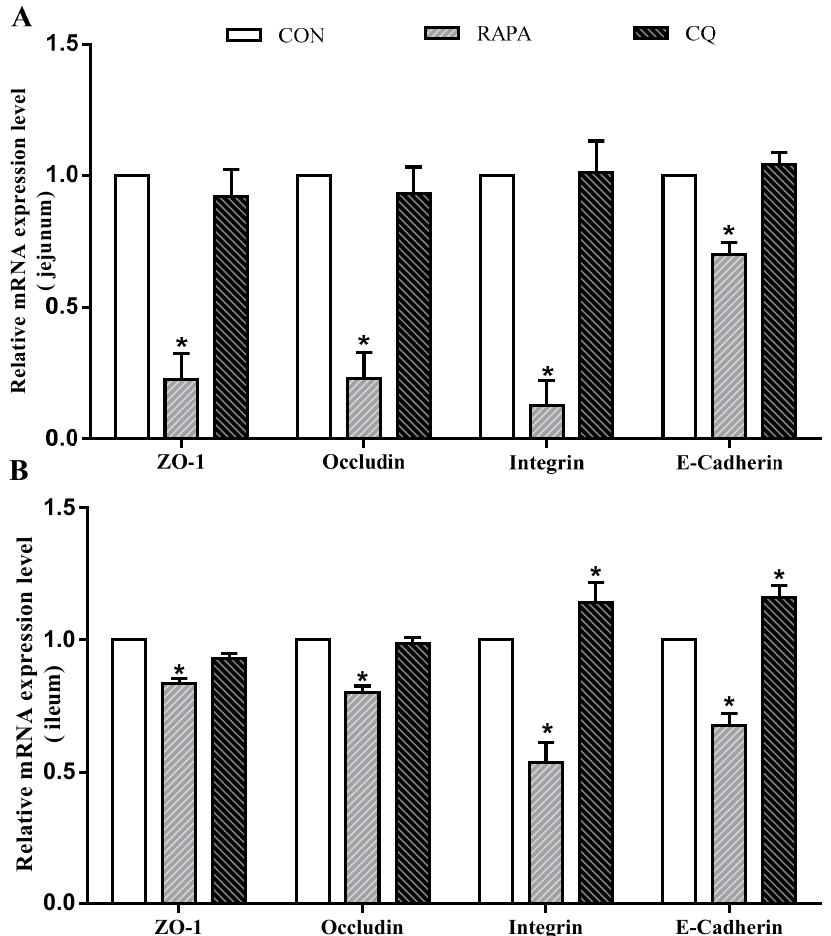
Figure 3. Relative mRNA levels. ( A ) E-cadherin , occludin , ZO-1 , and integrin mRNA levels on jejunum; ( B ) E-cadherin , occludin , ZO-1 , and integrin mRNA levels ileum. Dietary treatment: RAPA, rapamycin; CQ, chloroquine; CON, normal saline. Data are expressed as means ± SEM ( n = 6), all values are expressed in relation to the control. * p < 0.05 vs. control.